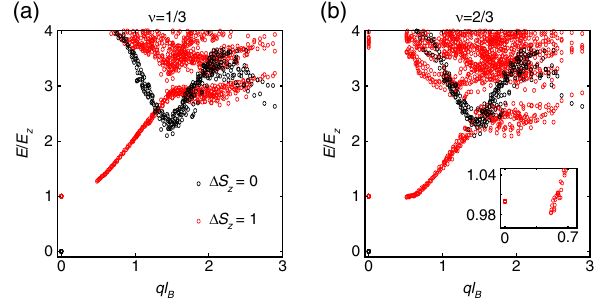
0 and 1 z ¼ ffiffiffiffiffiffiffiffiffiffiffi p ℏ =eB is the B ¼